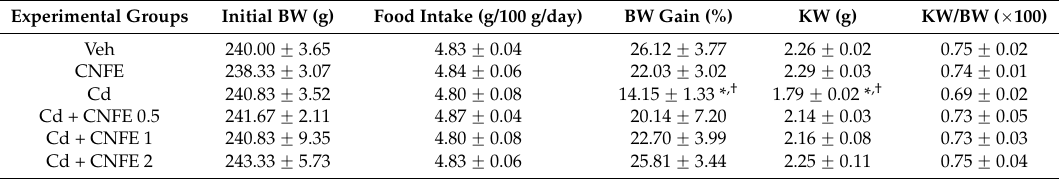
Table 2. Effects of CNFE on general characteristics of cadmium-intoxicated rats. Experimental